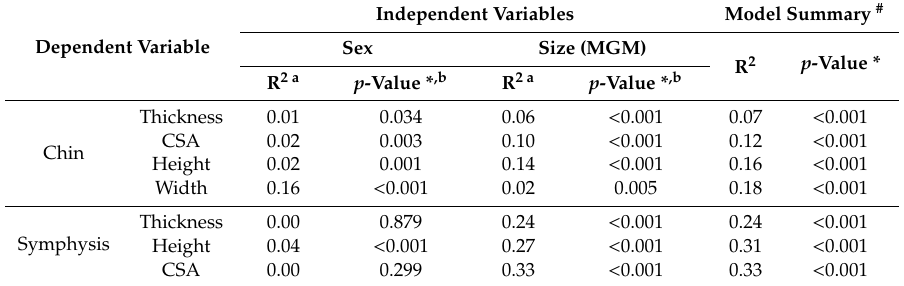
Table 9. The e ff ect of sex and size on the chin and symphysis (males n = 203, females n =